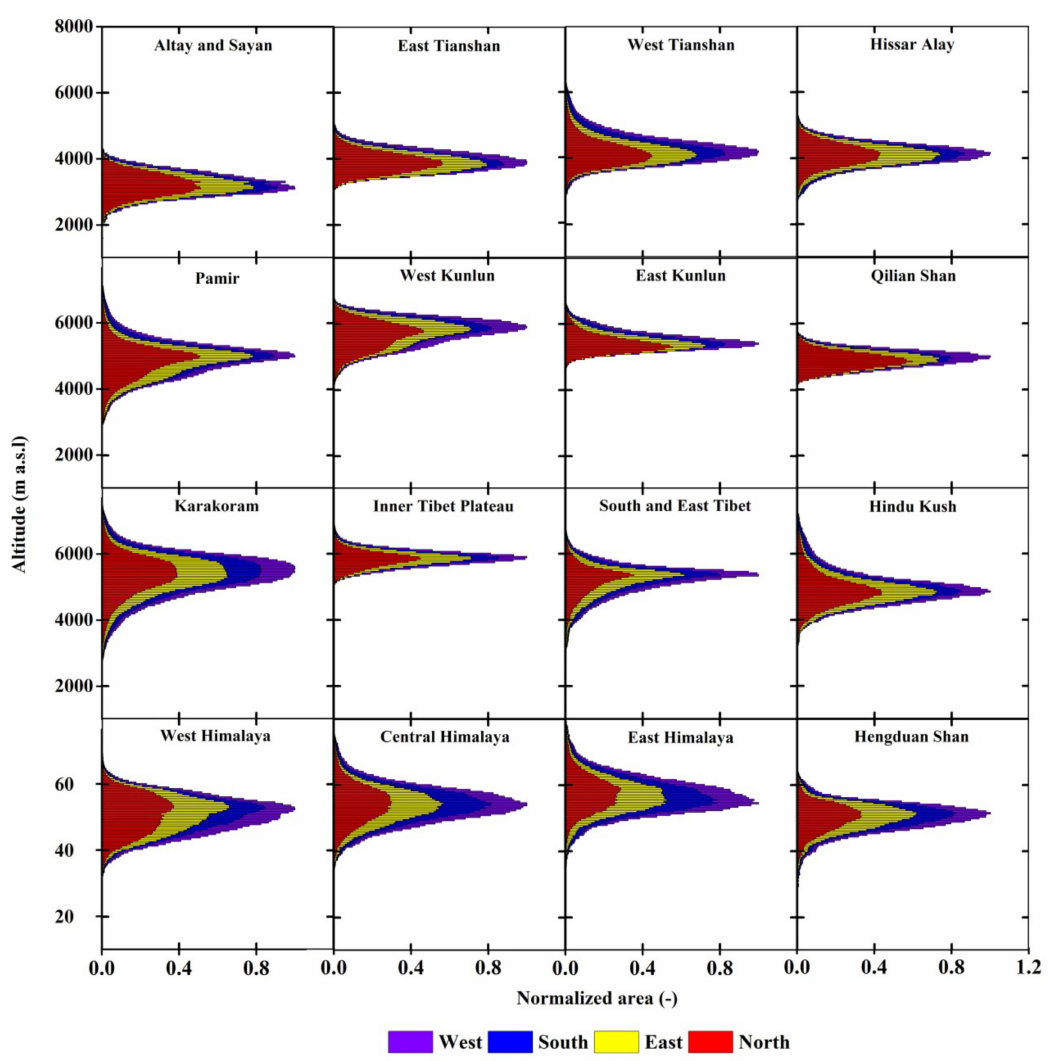
Figure 5. Altitudinal distribution of the topographic shading area within each region of HMA during the ablation